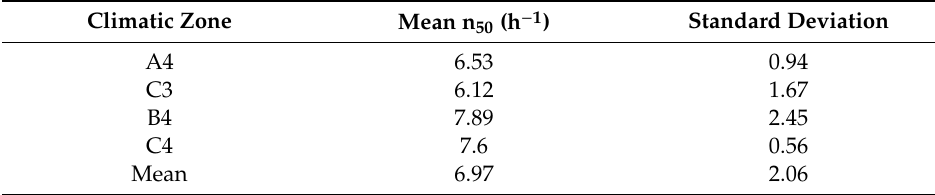
Figure 6. n 50 measured frequency. Table 6. Average values and standard deviation of n 50